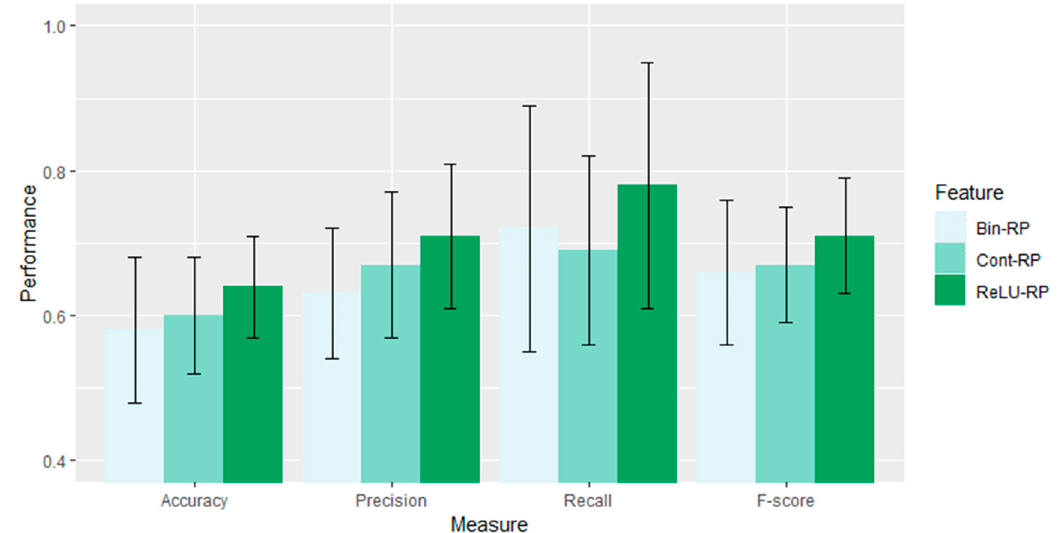
Figure 11. Comparison of the drowsiness detection performance of Bin-RP vs. Cont-RP vs. ReLU-RP in PPG. Table 4. Drowsy/awake classification performance using PPG band signals; performance measures were calculated based on 10-fold cross-validation.